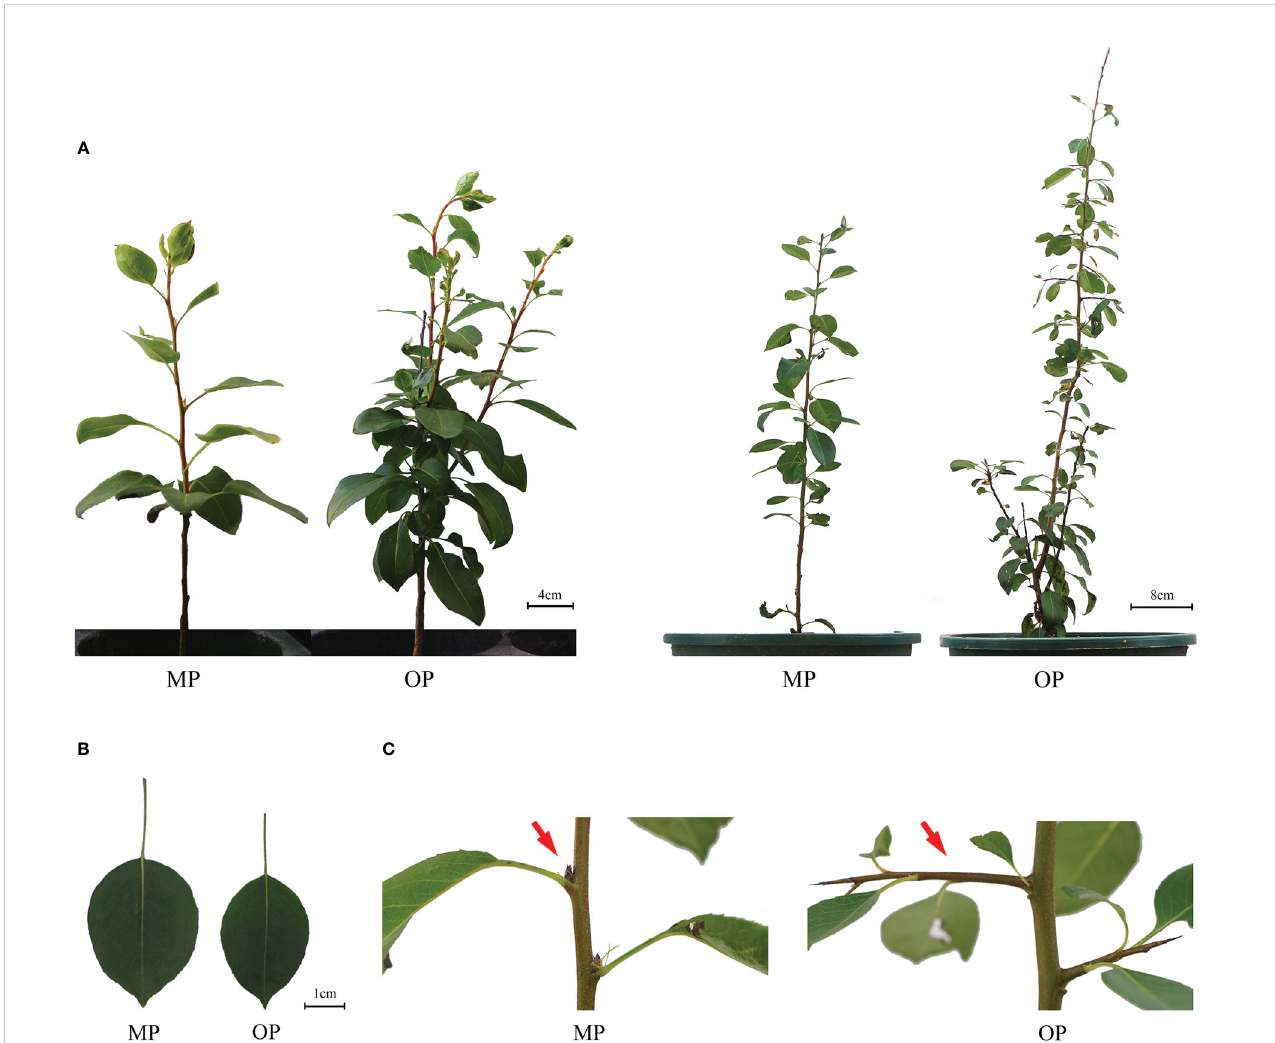
FIGURE 1 Phenotypes of the wild type (OP) and mutant (MP). (A) Plant phenotype of the same plant after growth for 9 months (left plant) and 12 months (right plant). (B) Leaf phenotype of MP and OP plants. (C) Axillary buds of MP and OP. The red arrow indicates transformation of the axillary meristem into a spur shoot (thorn) in OP and a dormant bud containing an undifferentiated axillary meristem in